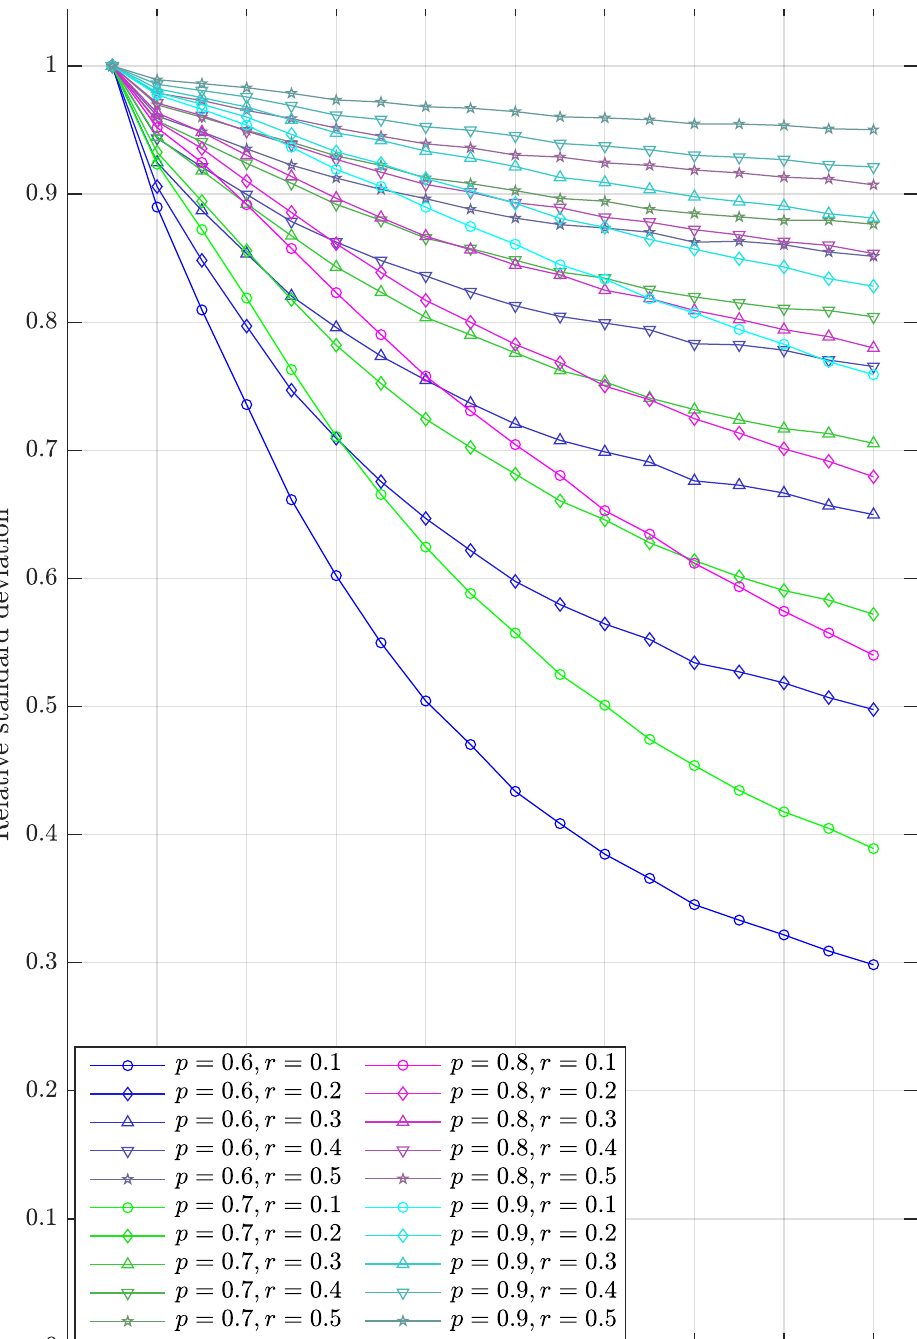
Figure 7. Relative standard deviation (heteroskedastic rms over homoskedastic rms) of the fitted curvature κ for all 20 combinations of p and r in the range 3 ≤ n ≤